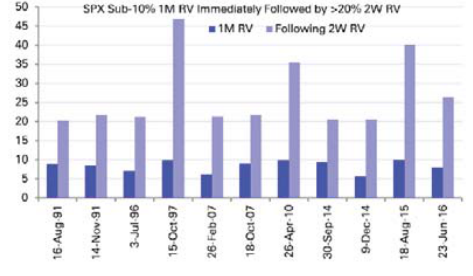
Fig. 1. Almost as many transitions from lows to highs over the past 7 years as in the prior 20 years Source: Deutsche Bank, Bloomberg Finance LP.